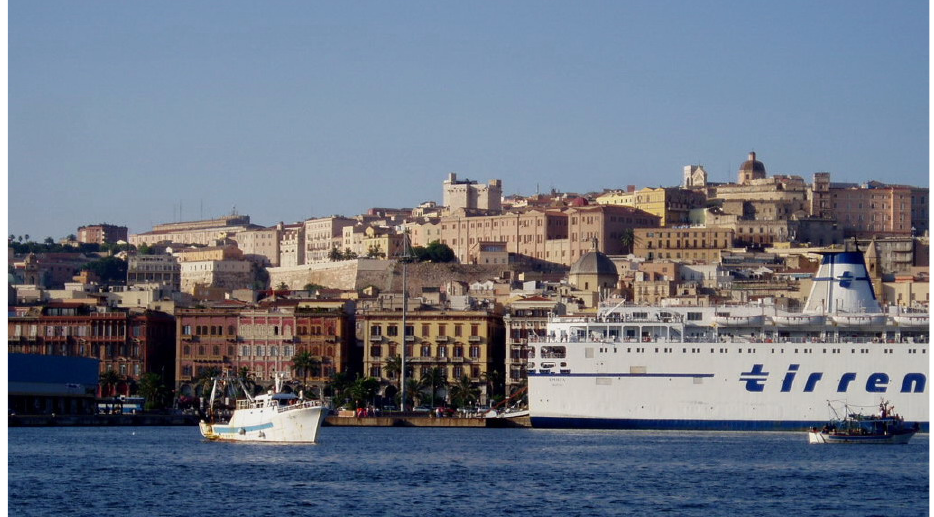
Figure 9. Cagliari cityscape (‘View of Cagliari from the sea’ by Cristianocani 2004/Wikimedia Commons is released under CC BY 2.0).